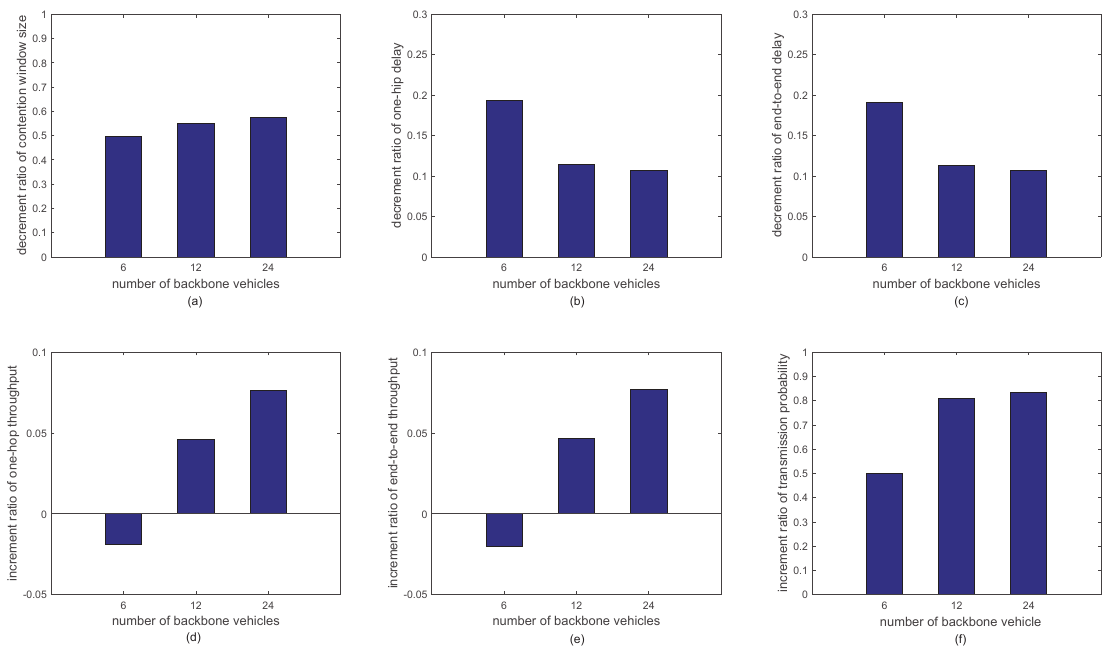
Figure 8. The average improvement ratio of the proposed approach’s performance under different numbers of backbone vehicles. ( a ) Decrement ratio of contention window size vs number of backbone vehicles; ( b ) Decrement ratio of one-hip delay vs number of backbone vehicles; ( c ) Decrement ratio of end-to-end delay vs number of backbone vehicles; ( d ) Increment ratio of one-hop throughput vs number of backbone vehicles; ( e ) Increment ratio of end-to-end throughput vs. number of backbone vehicles; ( f ) Increment ratio of transmission probability vs number of backbone